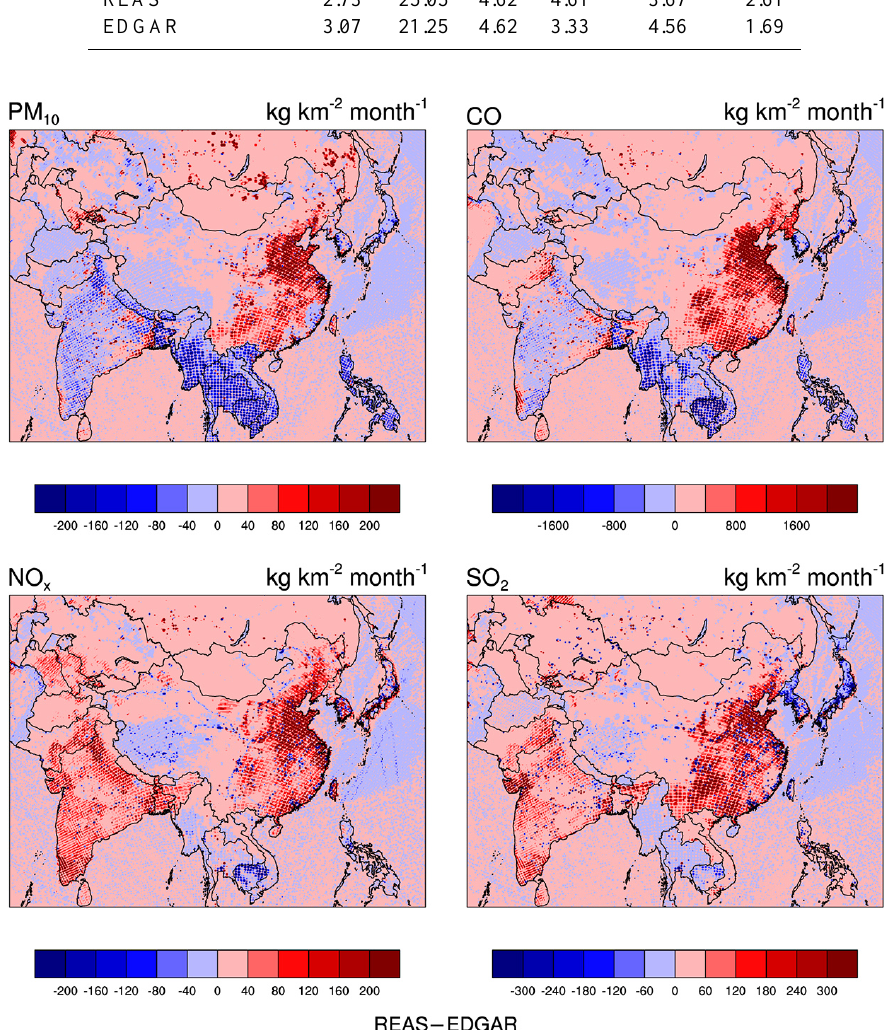
Figure 2. Monthly emissions difference of PM 10 , CO, SO 2 , and NO x between REAS and EDGAR in July 2007 in our model domain.